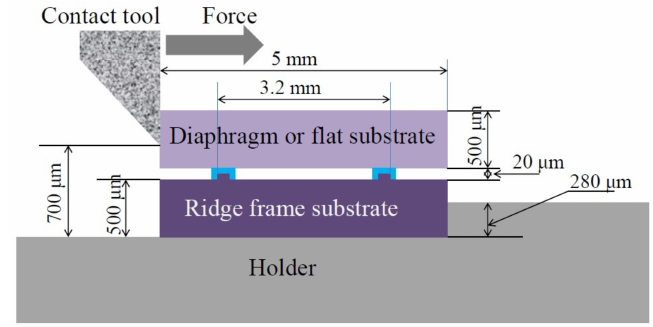
Figure 2. Schematic of bonding tester setup for die shear fracture strength